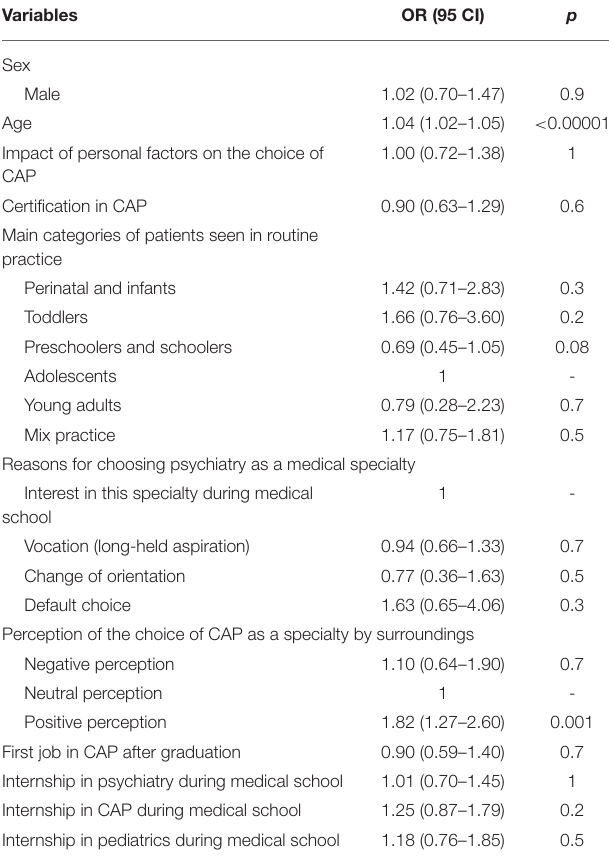
TABLE 5 | Multivariate model assessing the relationship between the perception of child and adolescent psychiatry as attractive and the detailed effects of different